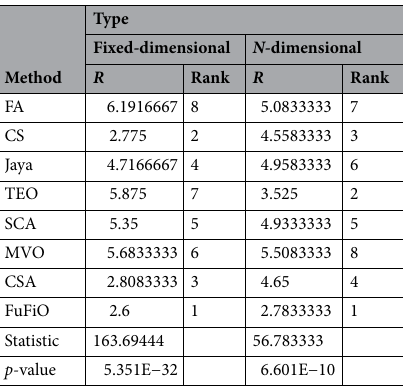
Table 8. The Friedman test results.